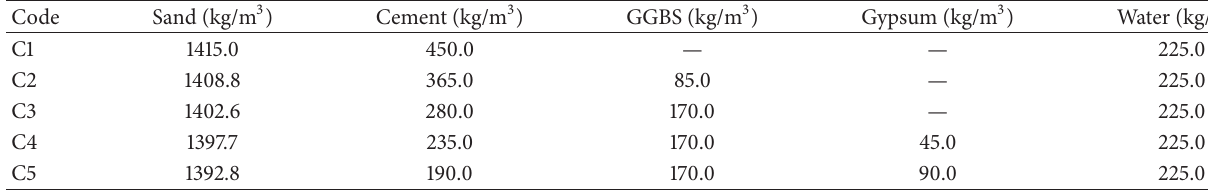
Table 2: Mixing proportions of samples by weight and the mix code.